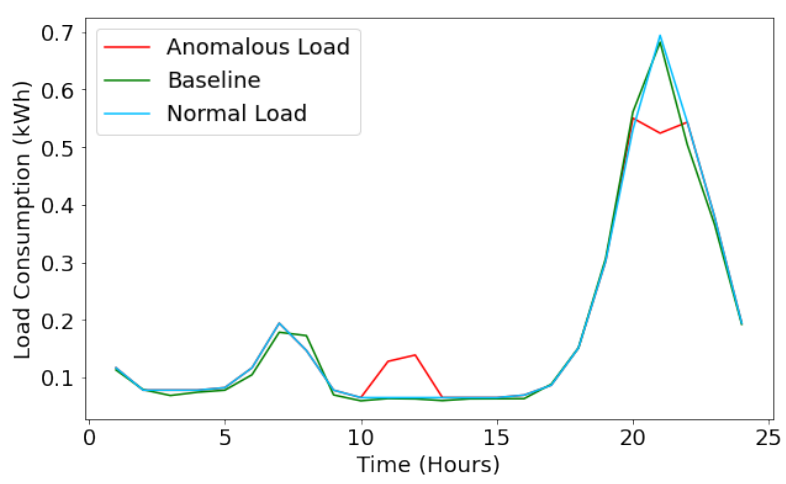
Figure 8. Energy loss prediction for AC.